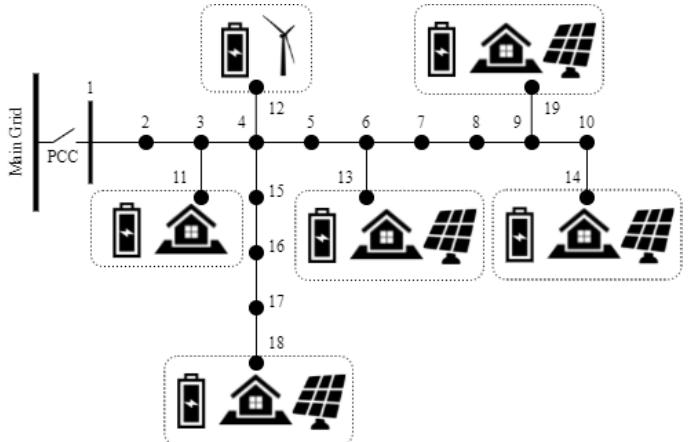
Figure 5. CIGRE 19 node test